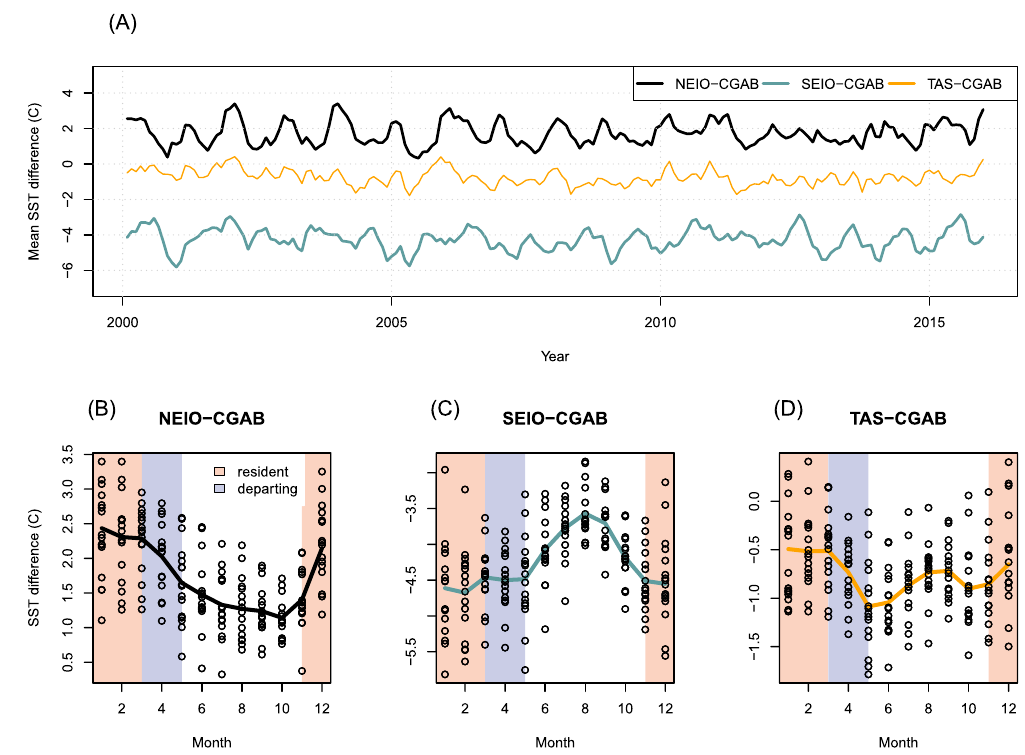
Figure 6. ( A ) Time series of the difference in sea surface temperature (SST) values from the central Great Australian Bight (CGAB) and those in the north-eastern Indian Ocean (NEIO), south-eastern Indian Ocean (SEIO) and Tasman Sea (TAS). ( B ) Monthly SST differences between the CGAB and the NEIO, SEIO and TAS areas across all years pooled. Lines highlight trends. Note that the y-axis scales vary between